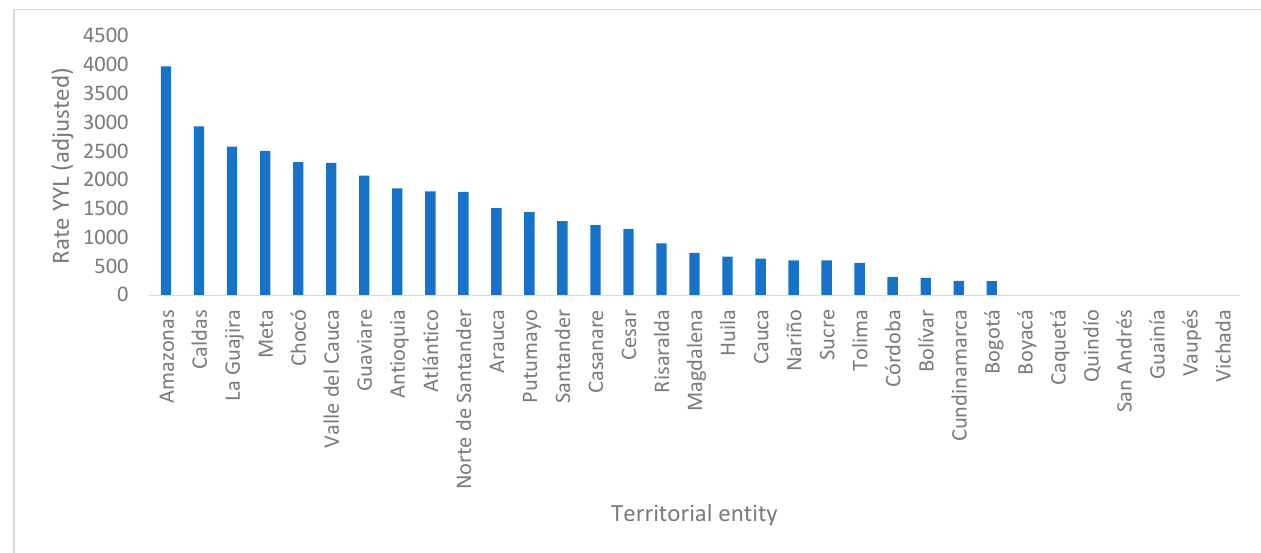
Figure A1. Death from tuberculosis by sex, territorial entities, Colombia, 2010–2018.